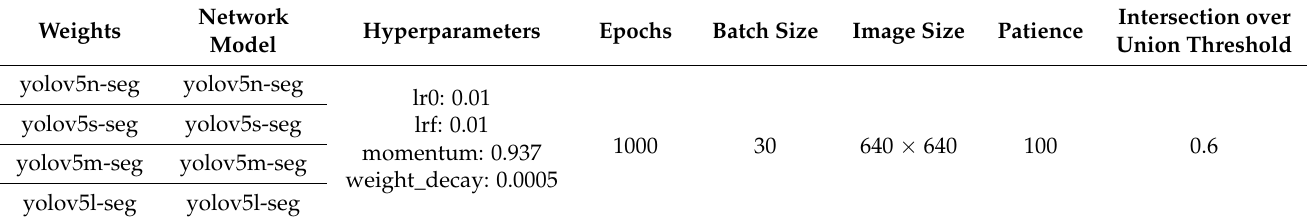
Table 2. YOLOv5 training parameters used in this research.